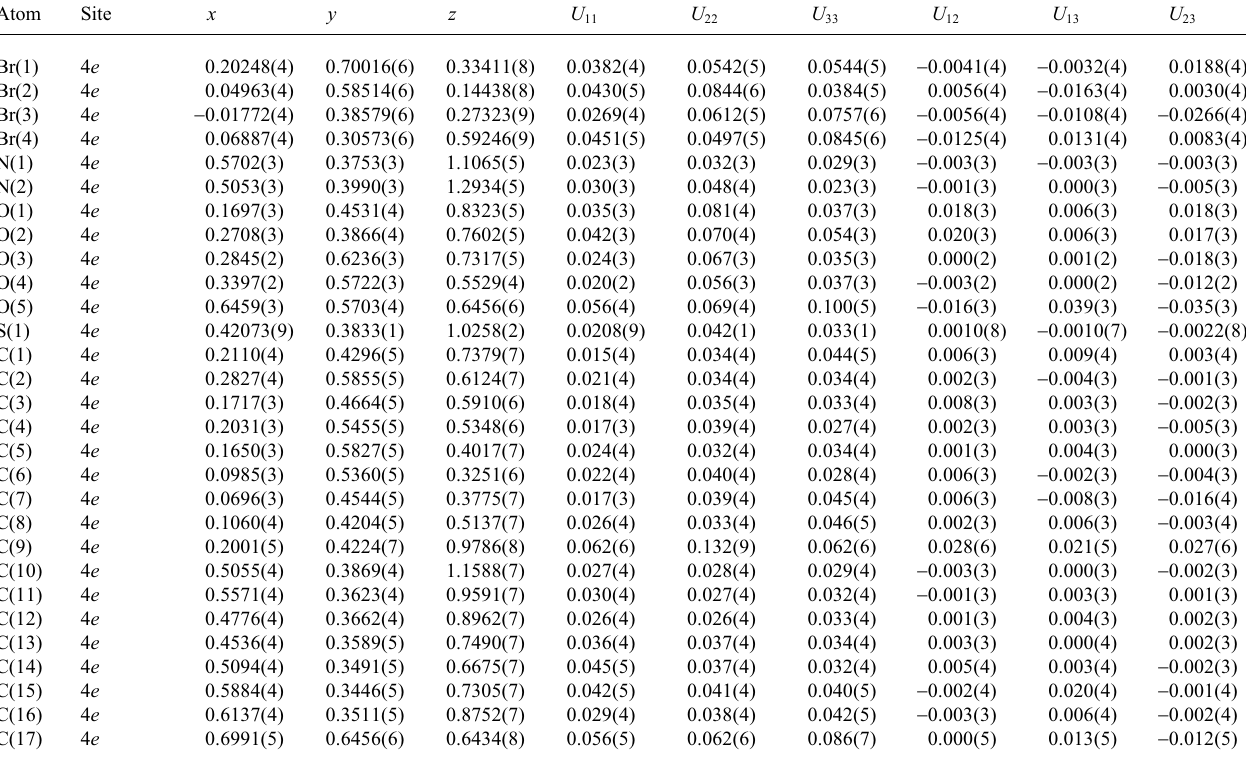
Table 3. Atomic coordinates and displacement parameters (in Å 2 )